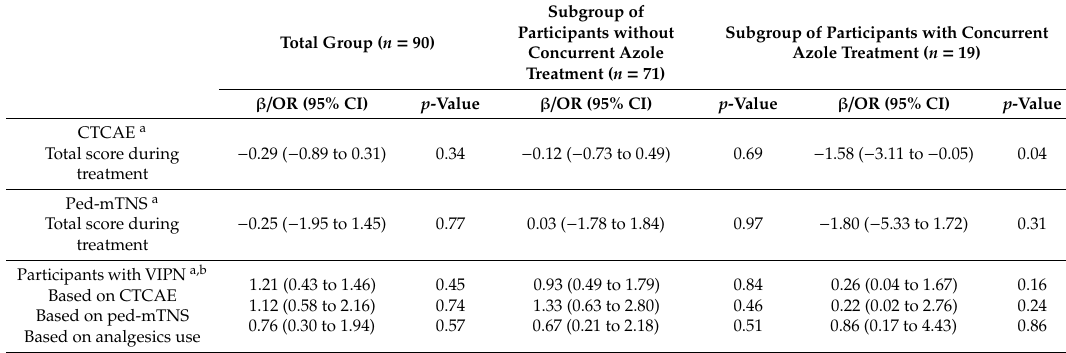
Table 3. The e ff ect of VCR administration method (push administration versus one-hour administration) on vincristine-induced peripheral